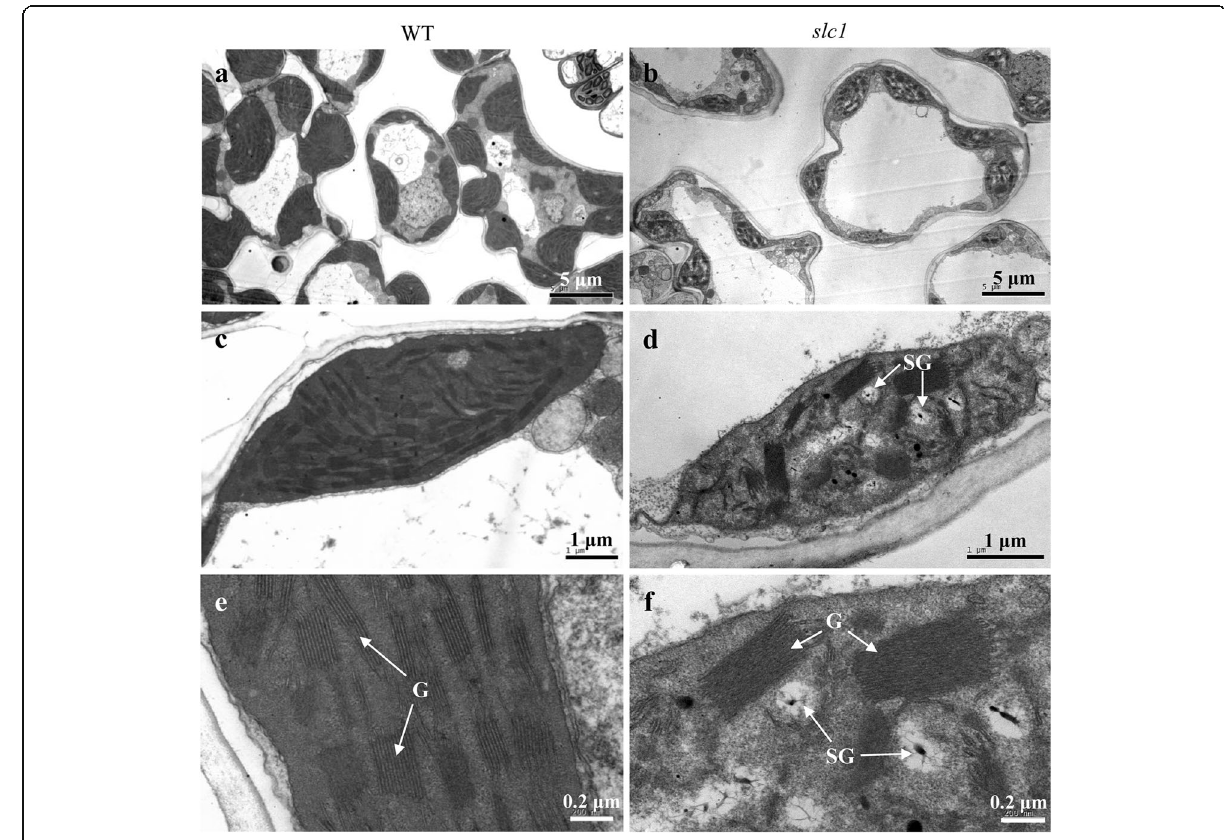
Fig. 2 Ultrastructure of chloroplasts in the wild type (WT) ( a , c , e ) and slc1 mutant leaves ( b , d , f ) at the third-leaf stage. G, grana; SG, starch grain. Scale bars are shown bottom